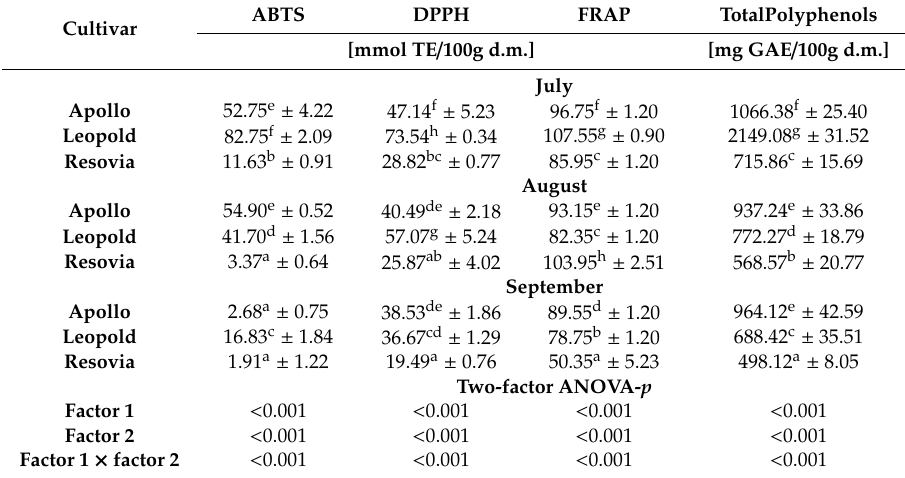
Table 2. Antioxidative potential of walnuts of di ff erent cultivars, in various stages of